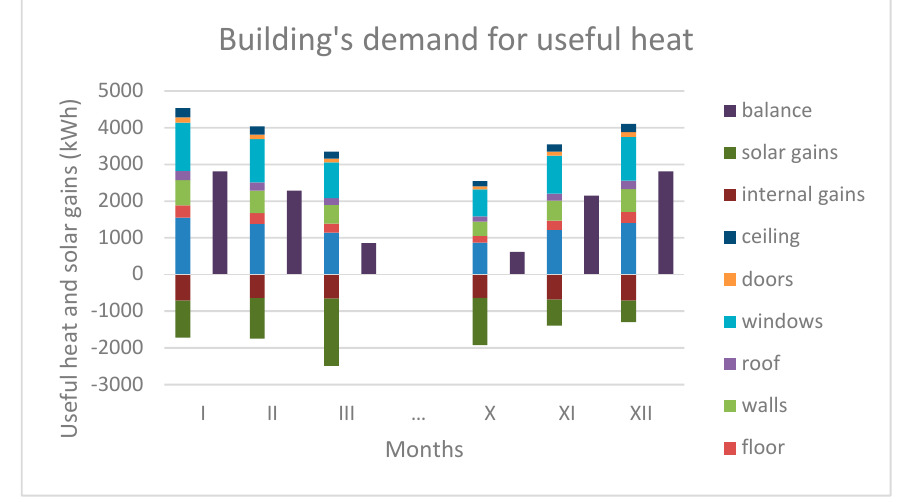
Figure 6. Monthly space heating demands with energy balance components: heat losses and gains.